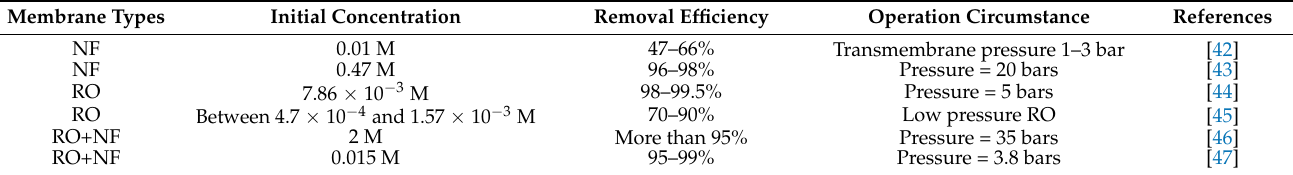
Table 2. Cu (II) removal